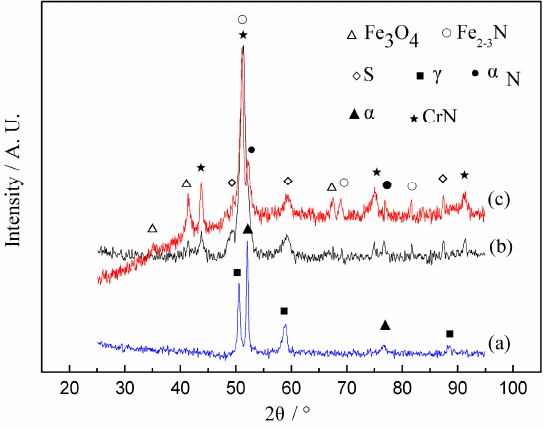
Figure 3. X-ray diffraction patterns of the substrate ( a ) and two specimens: ( b ) 570 °C; ( c ) 610